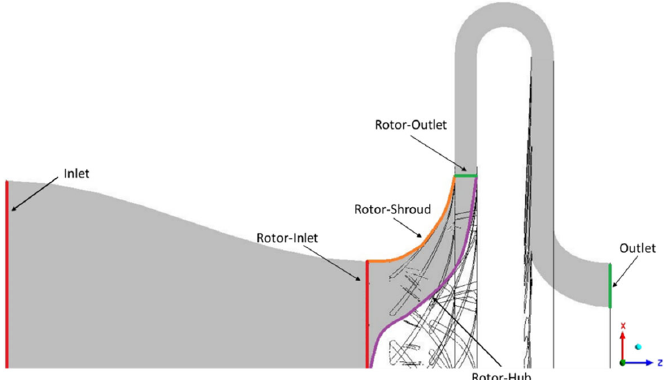
Figure 14. Schematic diagram of first stage compression meridian plane with R-513A refrigerant.